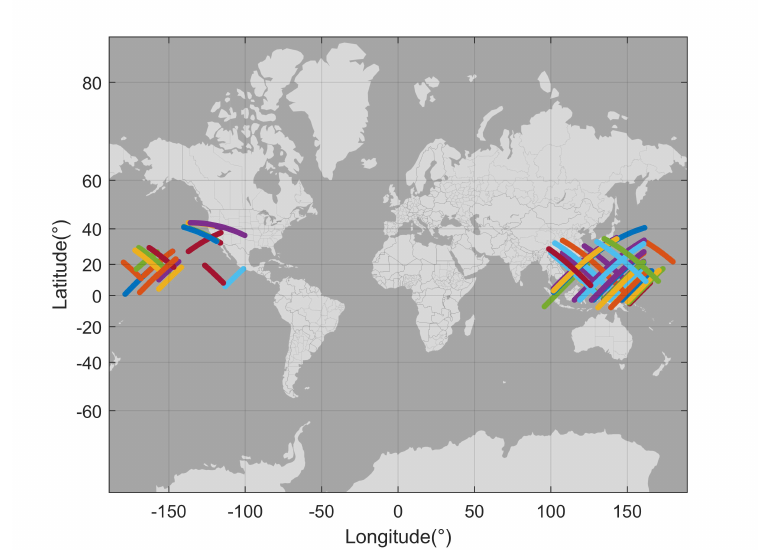
Figure 1. Sixty tracks of TG2-InIRA data used in this study.